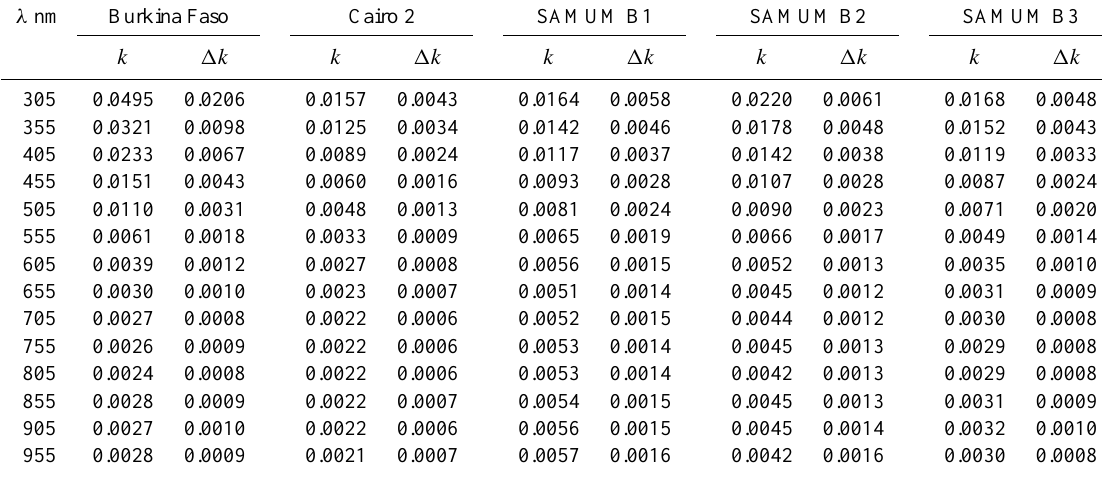
Table 5. Retrieval results for the imaginary part of the complex refractive index, k , at selected wavelengths, λ , for the five investigated Saharan dust samples. The tabulated data are mean k values from a set of individual measurements with SOAP. As explained in the text, the errors 1k account for the precision of the SOAP measurements as well as for the uncertainties associated with the retrieval